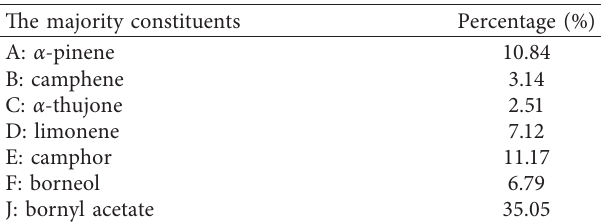
Table 1: Majority essential oil compounds of the aerial part of Tetraclinis articulata (Vahl)